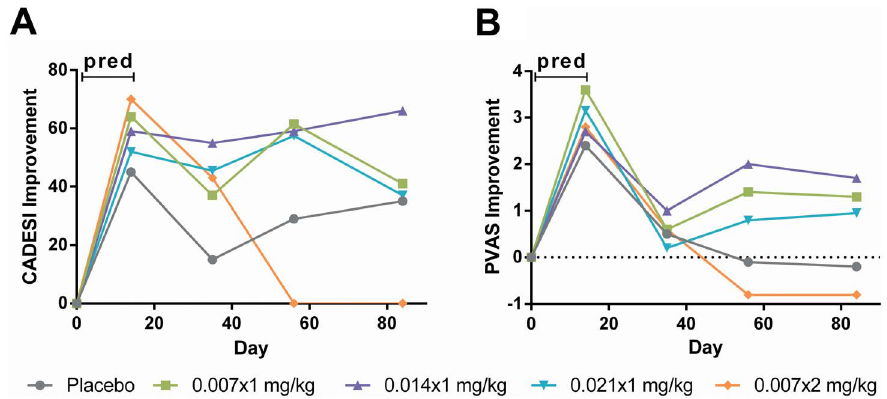
Figure 5. Change in CADESI and PVAS as a function of time in subjects treated with prednisolone and either placebo or LD- aminopterin. Subjects treated with prednisolone (pred) in the first 14 days ( N =62) were treated with either placebo ( N =13), or LD-aminopterin once-weekly (0.007 6 1 mg/kg, N =13; 0.014 6 1 mg/kg, N =13; 0.021 6 1 mg/kg, N =12) or twice-weekly (0.007 6 2 mg/kg, N =11). Median improvement in baseline (A) CADESI and (B) PVAS was determined at days 14, 35, 56 and 84. Abbreviations: CADESI, Canine Atopic Dermatitis Extent and Severity Index 03; PVAS, Pruritus Visual Analogue Scale; pred, prednisolone.